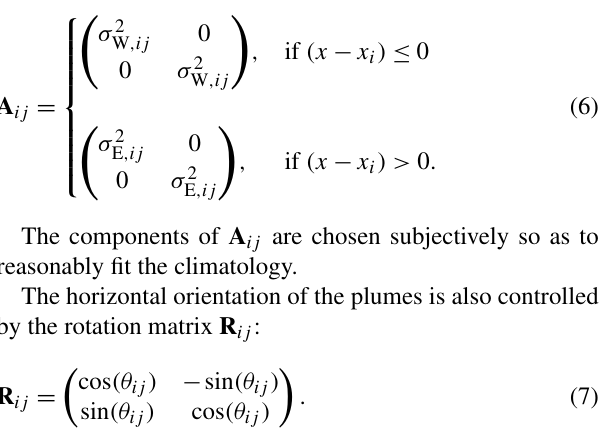
Figure 3. Annual (2005) mean anthropogenic aerosol optical depth (550nm) between 30 and 60 ◦ N for MACv2-SP (blue) and MACv2